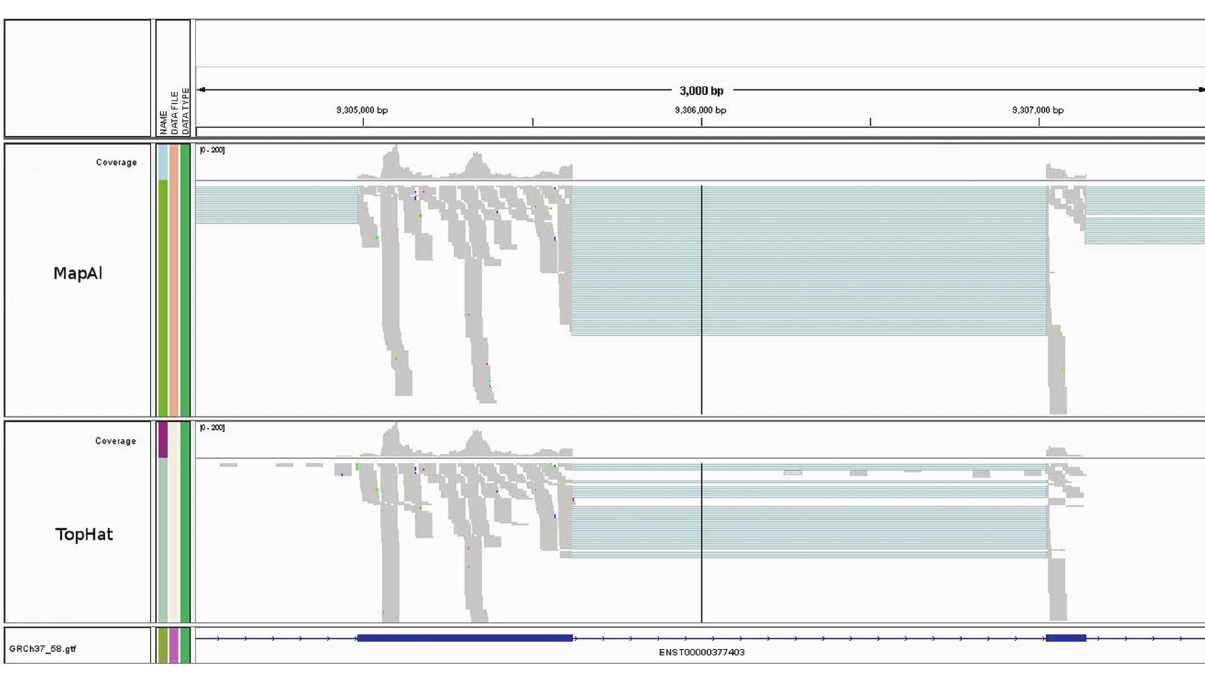
FIGUREA1 |Alignments to a typical transcript. The figure shows an IGV browser window (Robinson et al., 2011).The blue boxes represent the second and third exons of ENST00000377403 (H6PD).The gray coverage band at the